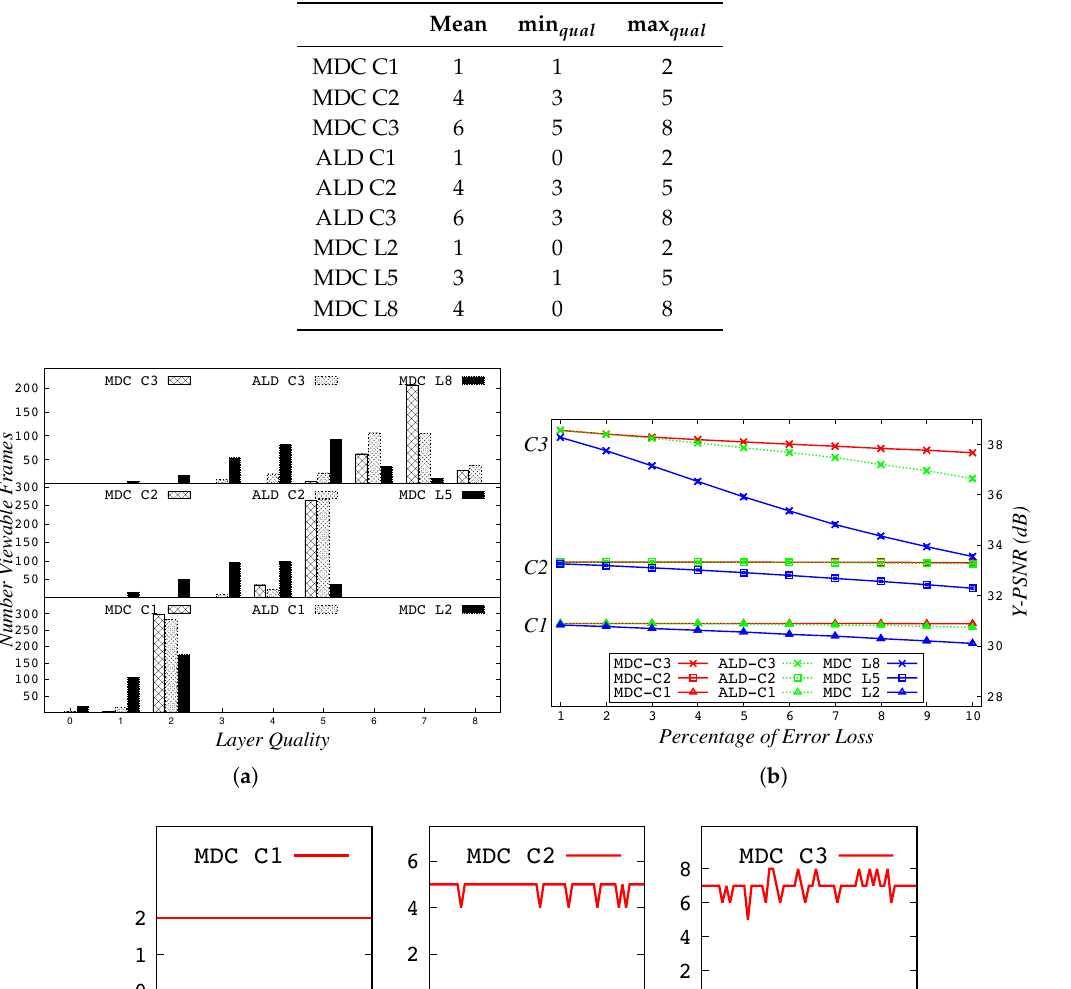
Table 11. Example of the mean layer value and the variation that occurs between maximum, max qual , and minimum, min qual , layer viewable quality over the duration of the clip.